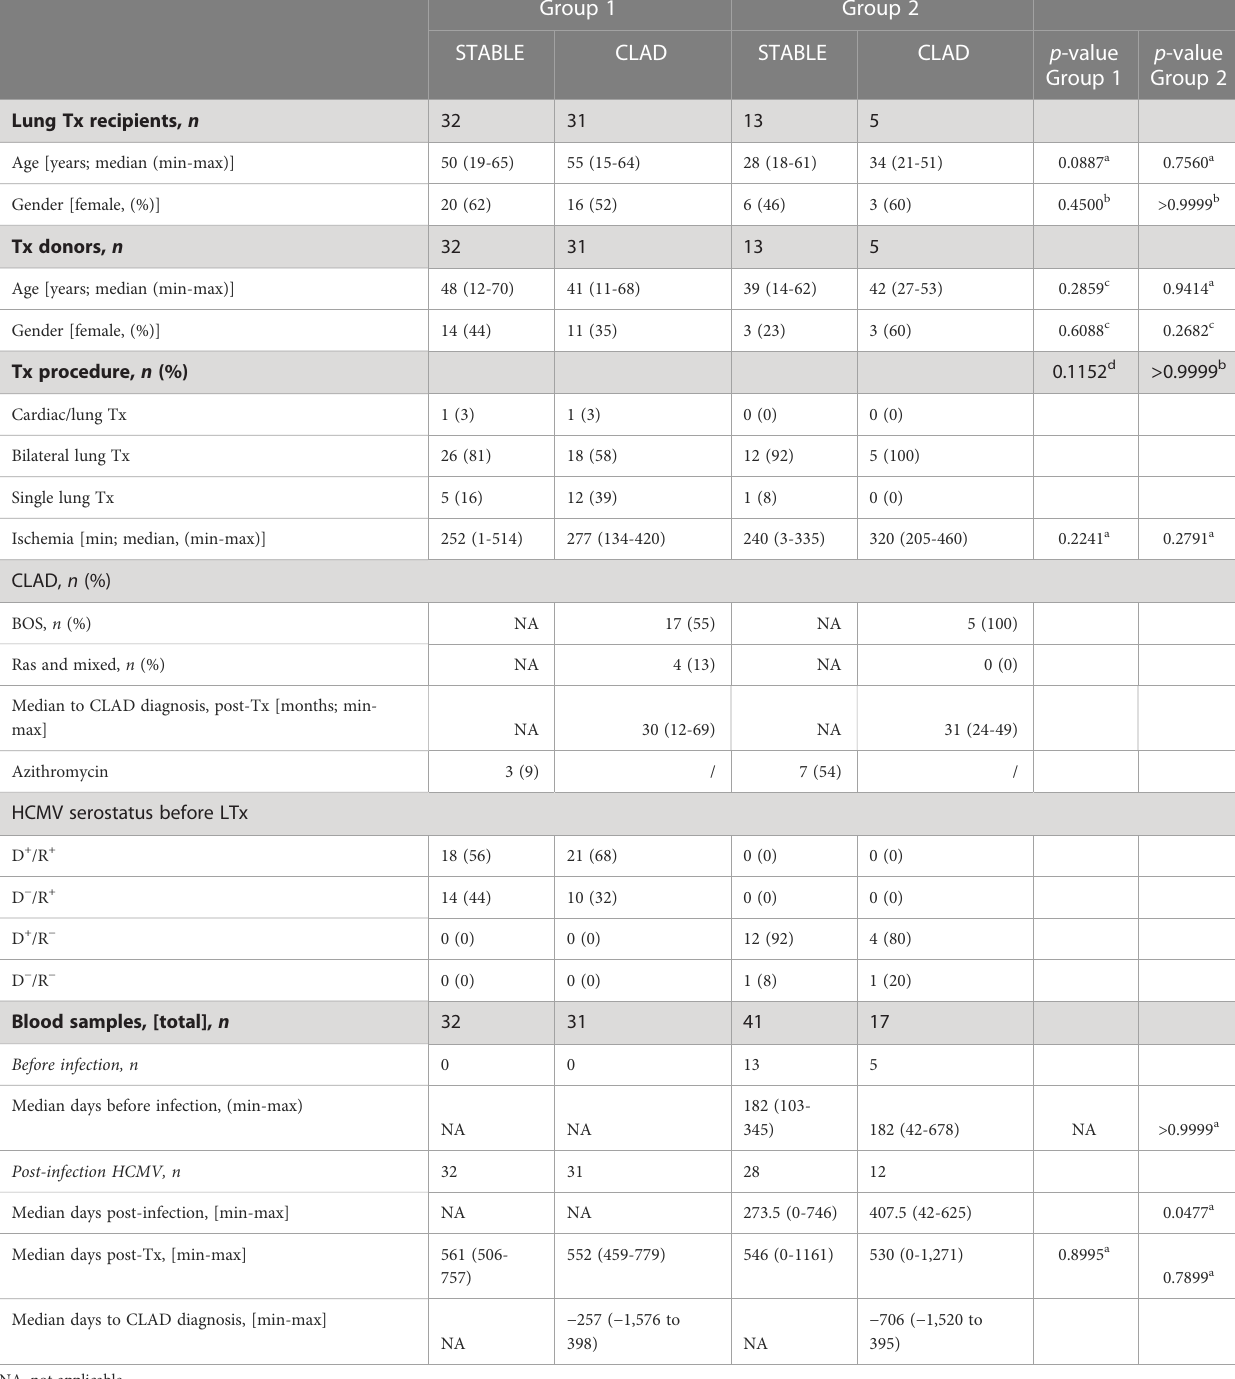
TABLE 1 Characteristics of the patients and